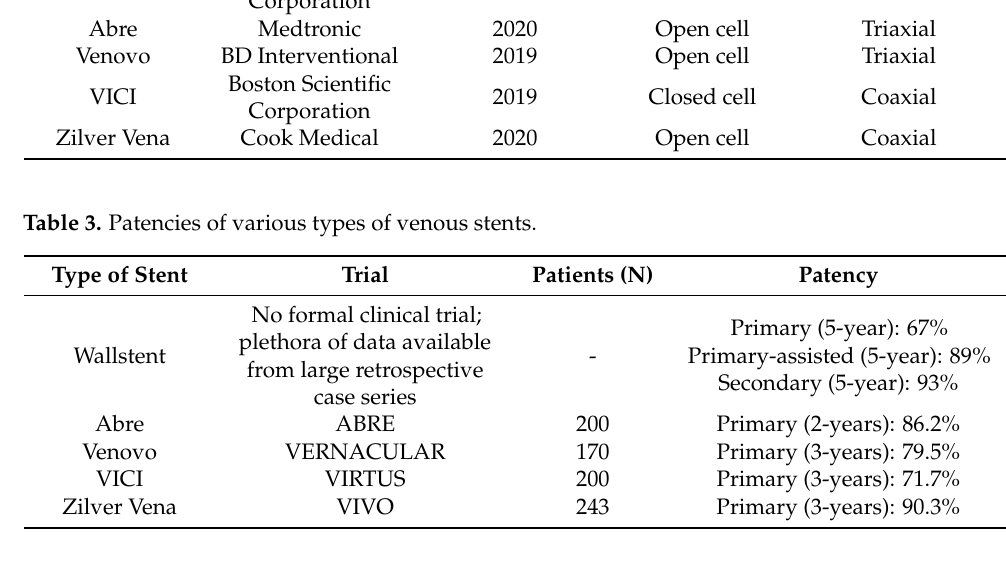
Table 2. Details of various types of venous stents. Type of Stent